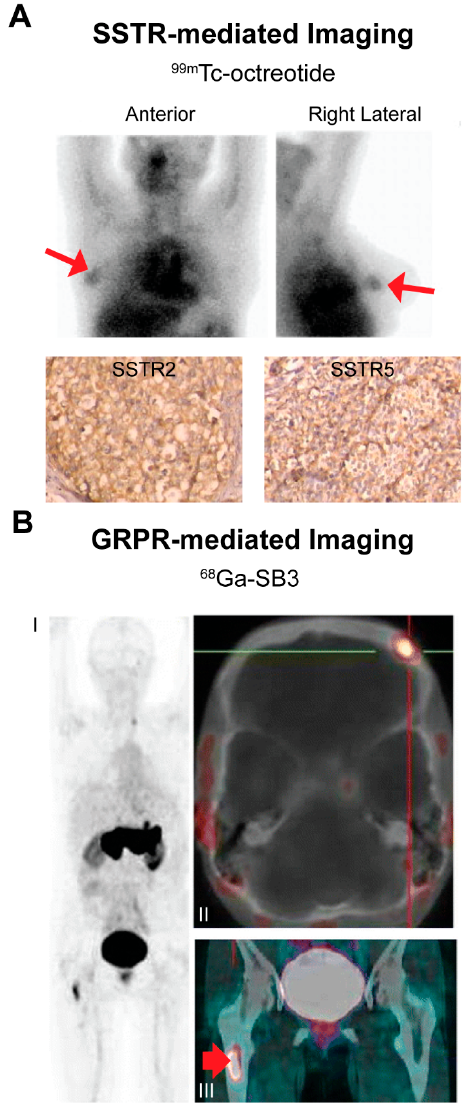
Figure 3. Examples of somatostatin receptor (SSTR)- ( A ) and gastrin releasing peptide receptor (GRPR)- ( B ) mediated breast cancer (BC) imaging. Images are adapted from studies by Wang et al. [64] and Maina and Bergsma et al. [80], respectively. ( A ) 99m Tc-octreotide (a SSTR-targeting